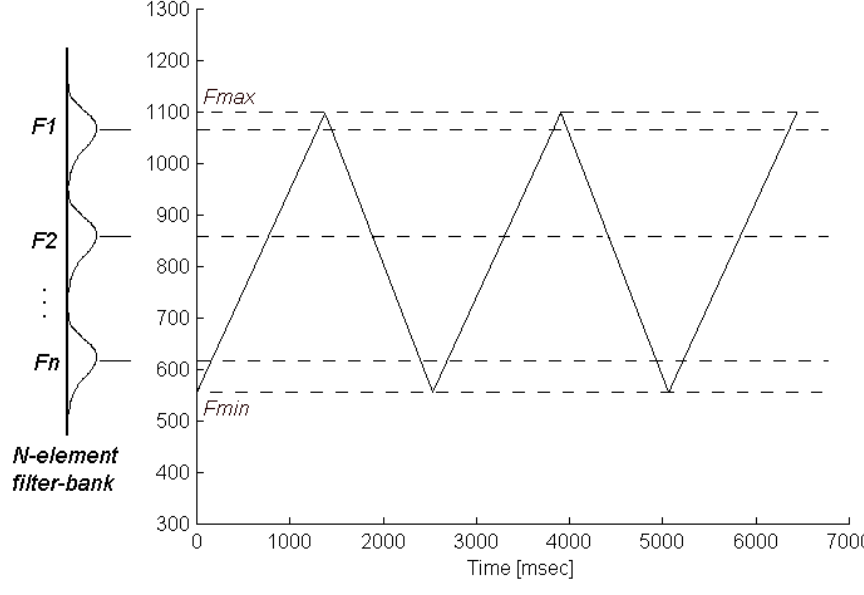
Figure 2. A filter-bank placed inside the dominant frequency range of a siren.